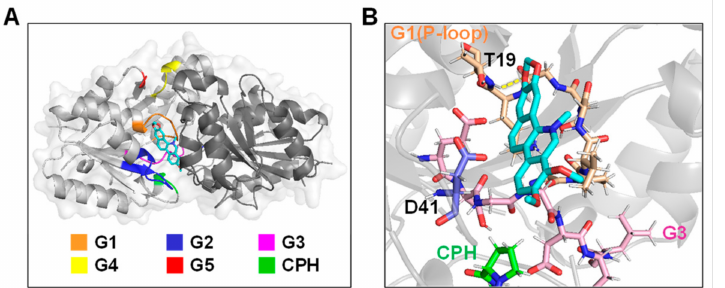
Figure 5. Binding mode of chelerythrine chloride with UreG. ( A ) Location diagram of chelerythrine chloride in UreG dimer. ( B ) Interactions between chelerythrine chloride and UreG. The structure of chelerythrine chloride is colored in cyan. Residue Thy19 makes a strong hydrogen bonding interaction (yellow dotted line) with an O atom of chelerythrine chloride. Conserved motifs of G1-G5 and CPH metal binding motif are colored as